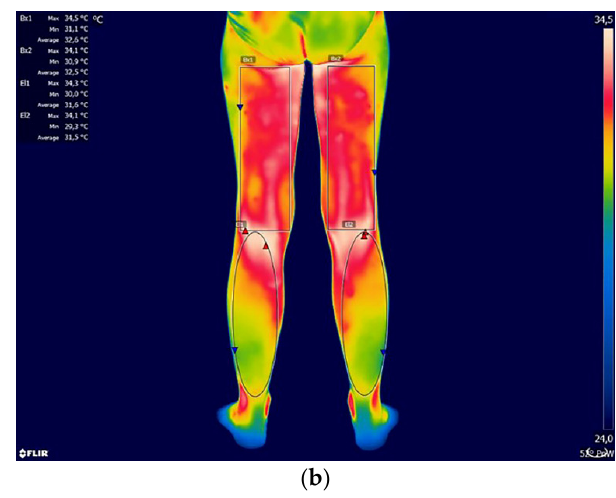
Figure 2. ( a ) Example thermogram with marked areas of the lower limbs (front): Bx1—tight right; Bx2—tight left; El1—shank right; El2—shank left. ( b ) Example thermogram with marked areas of the lower limbs (back): Bx1—thigh left Bx2—thigh right; El1—shank left; El2—shank